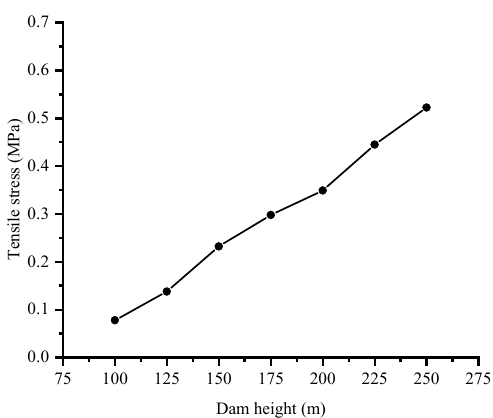
Figure 21. Relationship between tensile stress maximum of SACC and dam height.